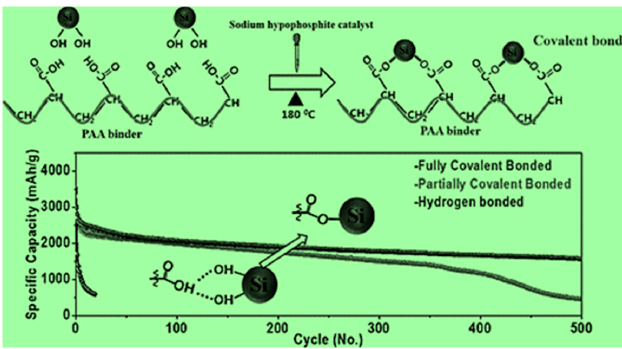
Figure 10. Stable Silicon anode for Lithium-ion batteries by Covalent Bond formation.